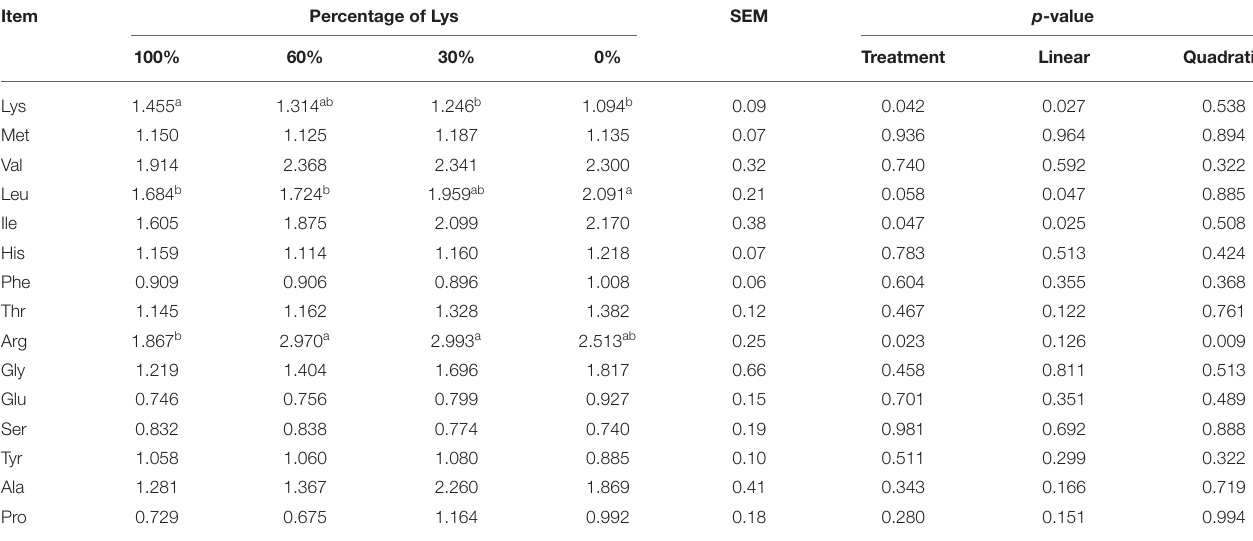
TABLE 9 | Effects of graded removal of Lys from the AA mixture infused into abomasum on the ratio of mammary uptake to milk output in lactating goats.